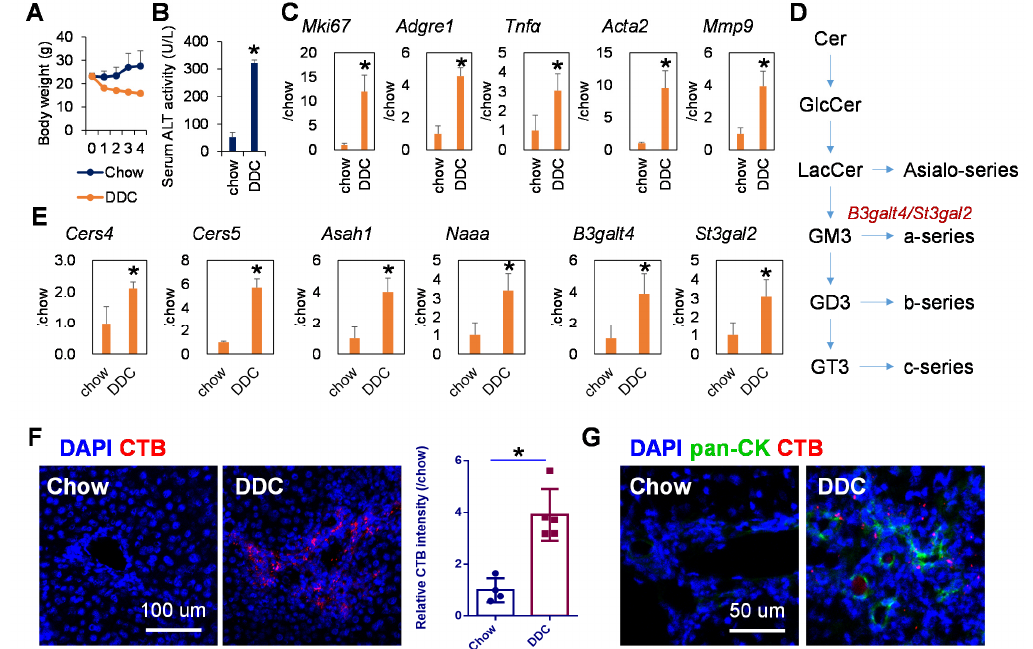
Figure 1. Enhanced ganglioside synthesis in the liver tissues of DDC-fed mice. ( A ) Changes in body weight of chow (n = 4) and DDC-fed mice ( n = 5). ( B ) Serum ALT activity and ( C ) expression of cellular proliferation marker Mki67 , inflammation-related genes Adgre1 and Tnf α , and fibrosis-related genes Acta2 and Mmp9 in the liver tissues of mice fed with chow or DDC for 4 weeks. ( D ) Schematic overview of ganglioside synthesis pathway. Cer, ceramide; GlcCer, glucosylceramide; LacCer, lactosylceramide; GM3, monosialo-tetrahexosyl-ganglioside 3; GD3, disialo-ganglioside 3; GT3, trisialo-ganglioside 3. ( E ) Expression of ganglioside synthesis genes Cers4 , Cers5 , Asah1 , Naaa , B3galt4 and St3gal2 in the liver tissues of mice fed with chow or DDC for 4 weeks. ( F ) Immunofluorescence staining of GM1 probe cholera toxin subunit B (CTB; red) in the liver of chow and DDC-fed mice (left), and the relative fluorescent intensity of CTB (right). Scale bar, 100 μ m. ( G ) Immunofluorescence staining of liver progenitor cell marker pan-CK (green) and GM1 probe CTB (red) in the liver of chow and DDC-fed mice. Scale bar, 50 μ m. Nuclei were stained with DAPI (blue). The data are presented as means ± SD. * p < 0.05 in Mann–Whitney U test.